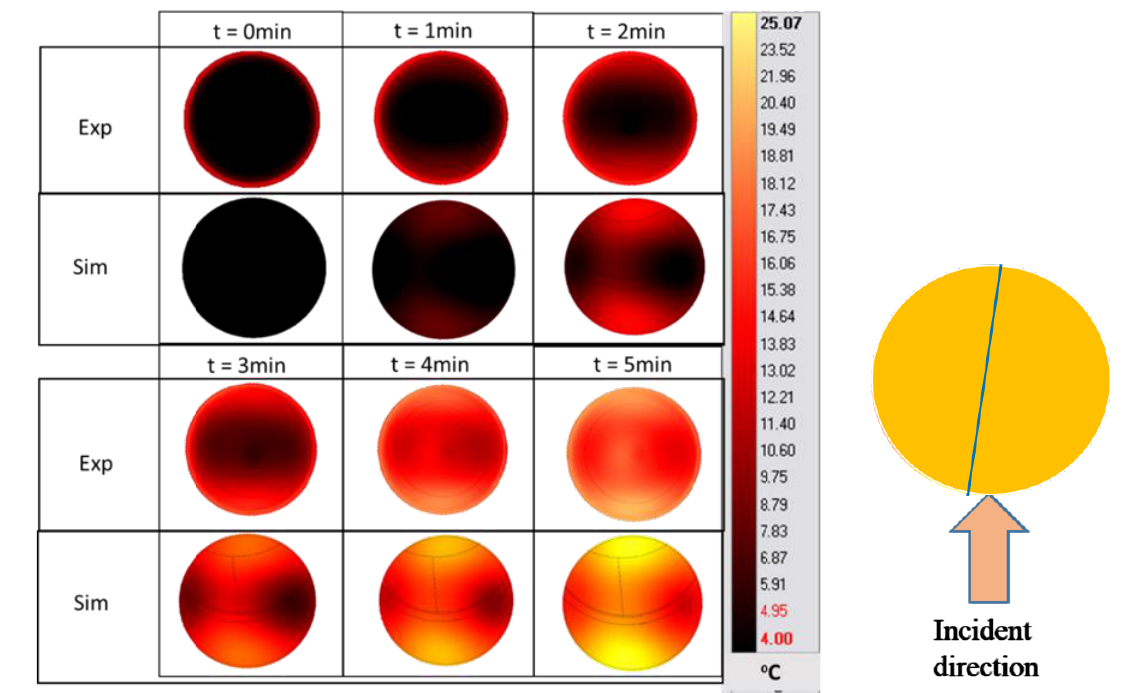
Figure 9. Surface-temperature cartography of Tylose ® during the ramp-up heating period at position A. (The blue line is the temperature sampling line used in Figure 10).